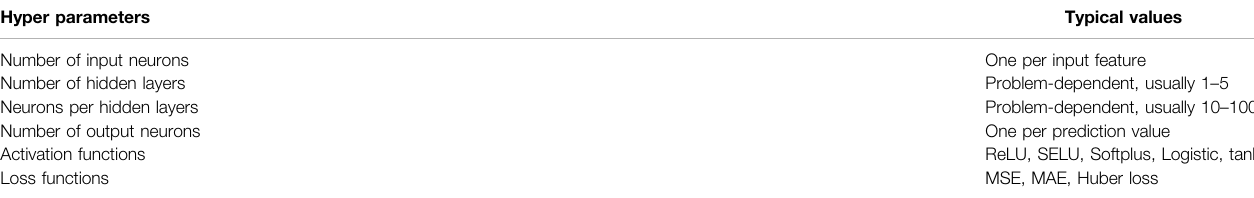
TABLE 1 | Common hyper-parameters for